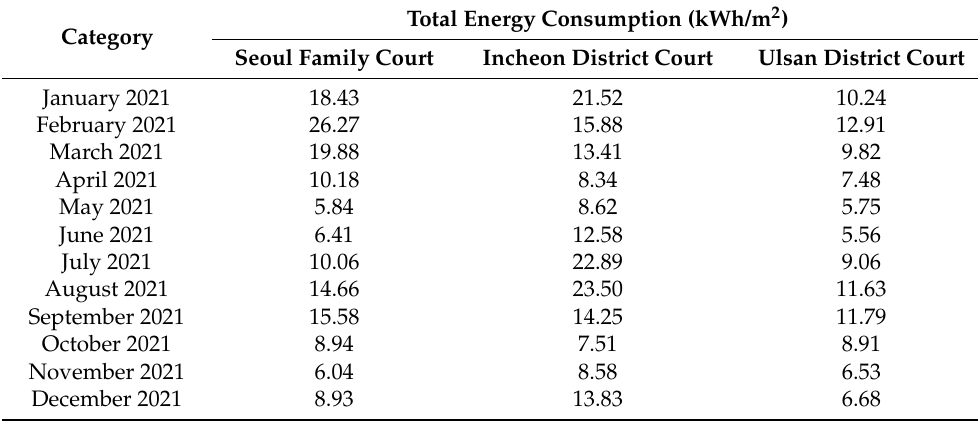
Table 9. Total energy consumption of Korean courthouse buildings (G-SEED non-certified and before insulation thickness standard